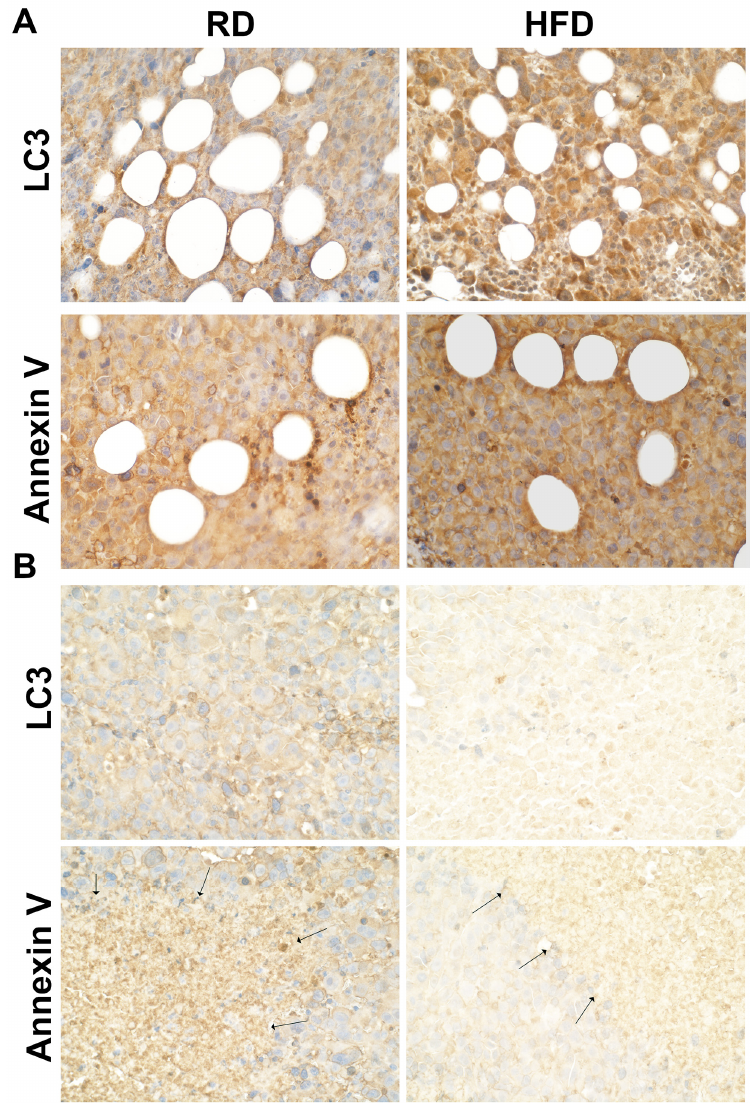
Figure 7. HFD increases autophagic apoptosis at the early tumor point and decreases it at a later stage of tumor growth as demonstrated by IHC in tumor sections. ( A ) The markers of autophagy (LC3) and apoptosis (Annexin V) significantly increased in short-term HFD-fed mice compared to RD-fed mice at 2 wpi; ( B ) however, the levels of these markers significantly decreased at 5 wpi in both RD- and HFD-fed mice compared to 2 wpi (black arrows indicate the invasive front associated with adipocytes) (40× magnification).